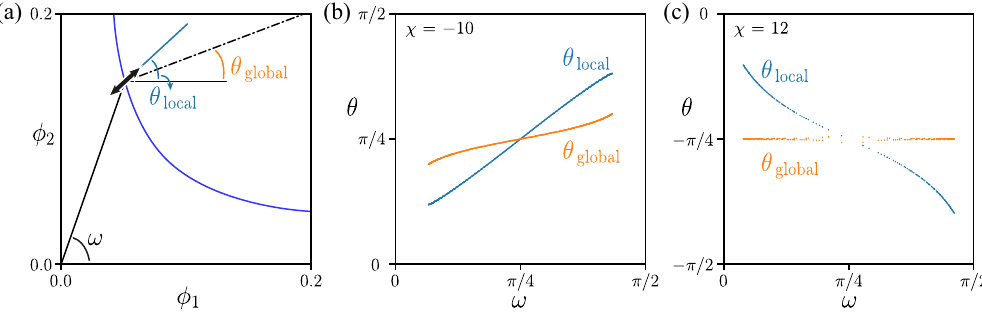
FIG. 4. Comparison between tie-line directions calculated numerically using global equilibrium conditions (orange) and analytically through the local Hessian matrix (blue). (a) Illustration of notations used. The blue curve is the binodal phase boundary, the black dot- dashed line is the numerical tie line, and the thick arrow indicates the less stable direction of the local free-energy Hessian. (b) Tie-line angles for associative phase separation with an attractive χ ¼ − 10 , and (c) with a repulsive χ ¼ 12 . The local gradient tends to align with the ϕ 1 ¼ 0 and ϕ 2 ¼ 0 axes when the sample point is close to either axis, respectively, as a result of the high local curvature of the free- energy surface at low